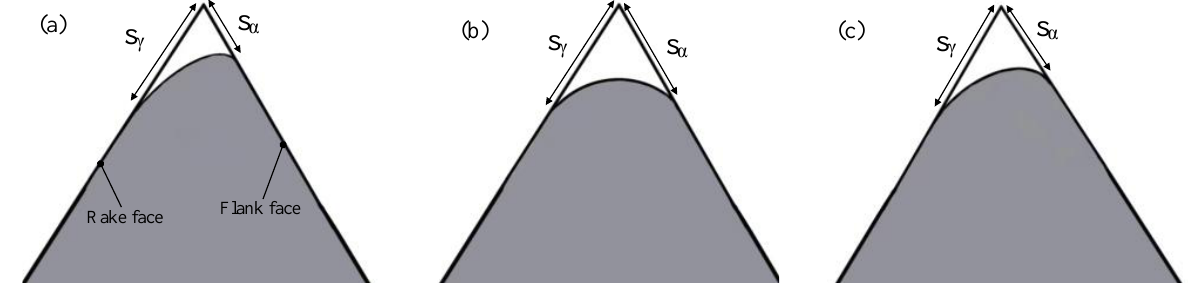
s α s γ (b) s α s γ (c) Figure 10. Schematic diagram of the change of K -factor: ( a ) initial, K = s α /s γ = 0.14, ( b ) − 20° , K = s α /s γ = 0.56, ( c ) 20°, K = s α /s γ = 0.26. The schematic illustration of cutting edge preparation at different polishing angles is shown in Figure 11, where v 1 and v 2 are the flow velocity of the polishing slurry along the flank and rake face, respectively. When the polishing angle is − 20°, the polishing slurry almost impacts the edge of the insert and the relative speed between the polishing slurry and the edge decreases. As soon as the polishing slurry reaches the cutting edge, it divides into two streams, one of which flows to the rake face, v 2 gradually decreases to 0 due to the action of friction and gravity. Another slurry flows to the flank face to polish the flank face with the flexible fiber. When the polishing angle is − 10°, the relative motion rate of the polishing slurry and the cutting edge increases, and the material removal rate at the tip of the insert increases. When the polishing angle is 0°, the polishing slurry converges